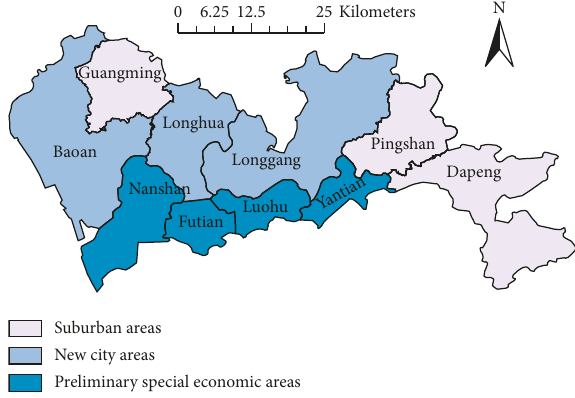
Figure 1: Administrative districts in